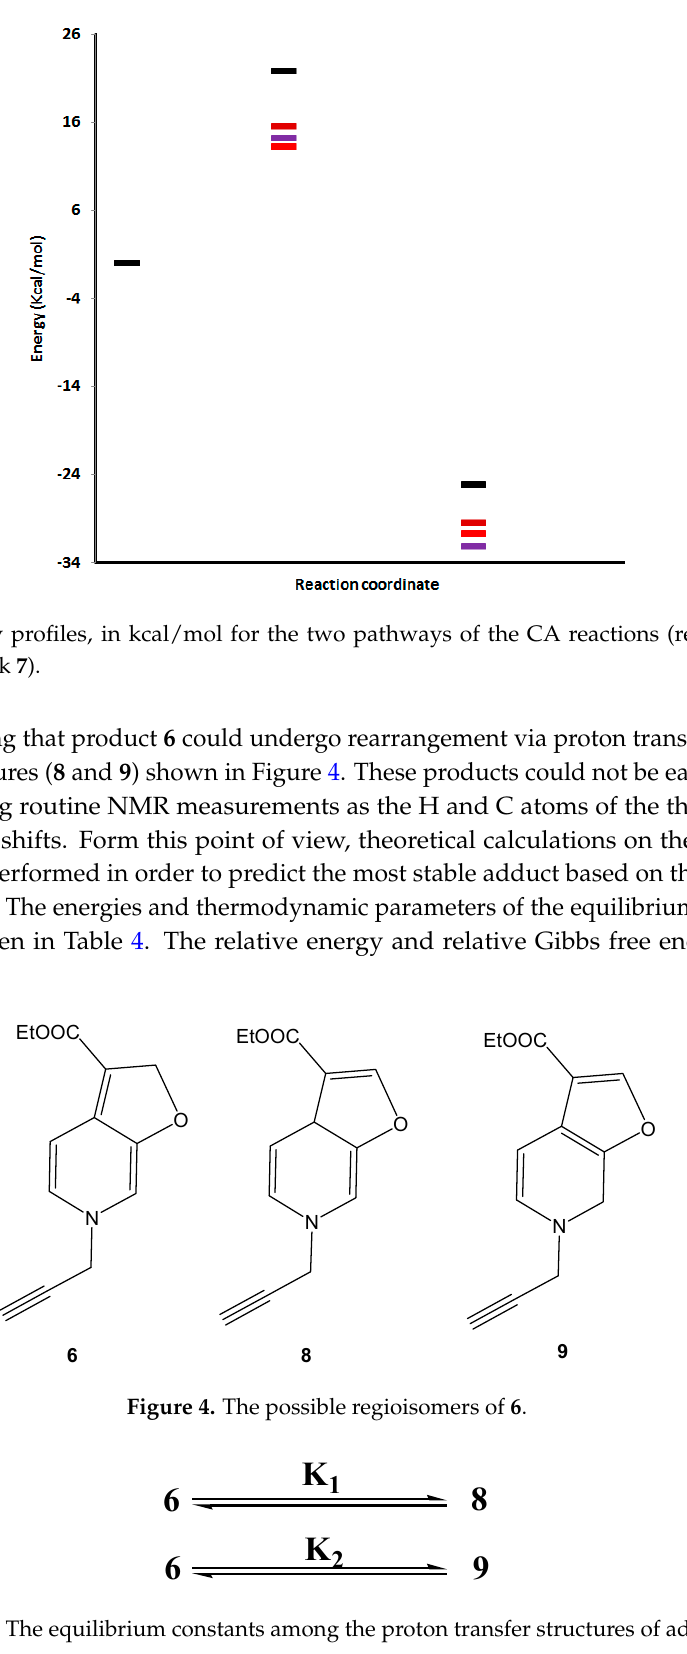
Figure 2. The four transition state structures of the studied CA reaction.